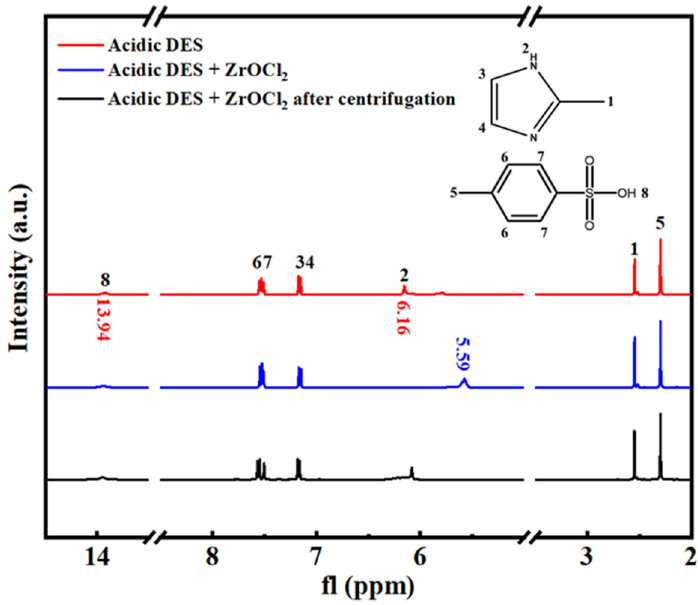
Figure 8. 1 H NMR spectra of acidic DES and acidic DES within ZrOCl 2 .